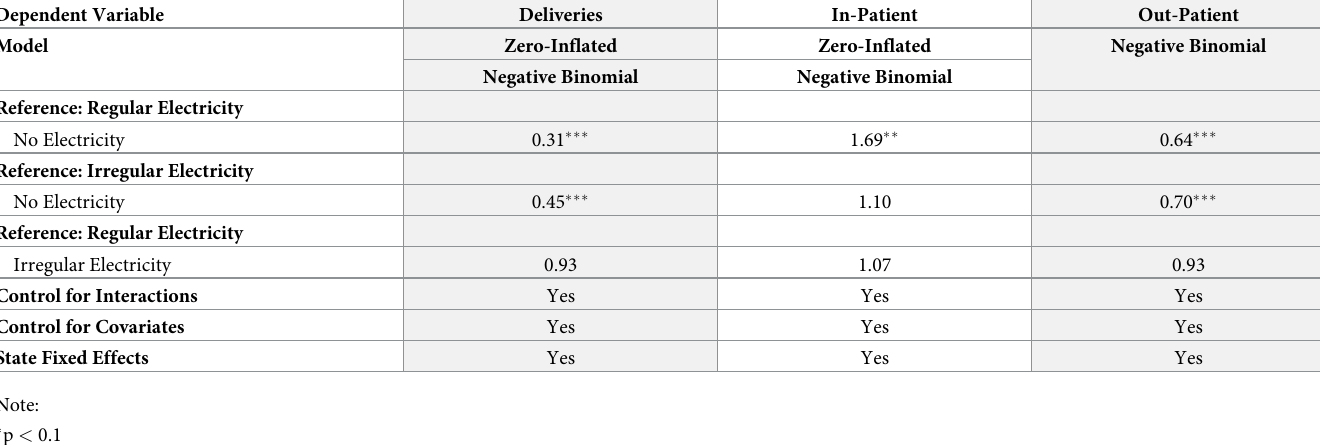
Table 5. Sub-sample regressions: Incidence Rate Ratios (IRR) (exponentiated log-odds) for the focal variables in the regression models for three outcome variables of interest, tested with two categories at a